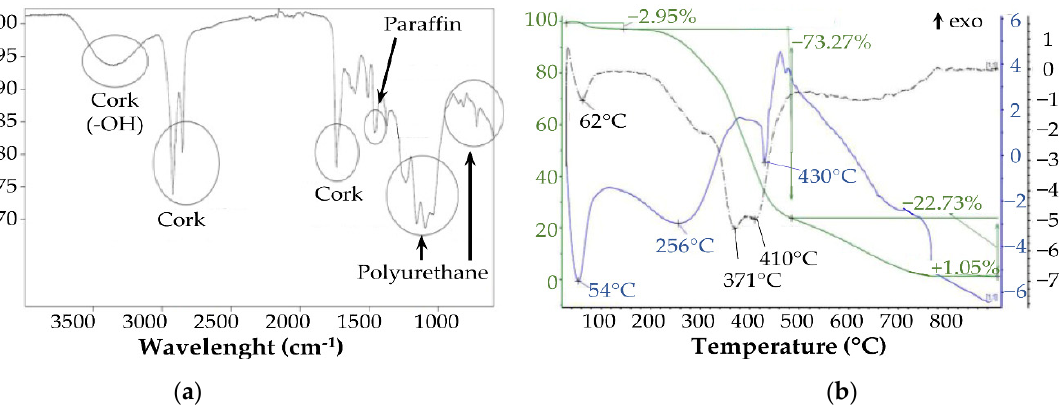
Figure 1. Composition of cork waste through ATR FT-IR analysis ( a ) and STA analysis ( b ). In Figure 1b are displayed the following curves: TGA (green line), first derivative of TGA (DTGA, black dashed line) and DSC (blue line).